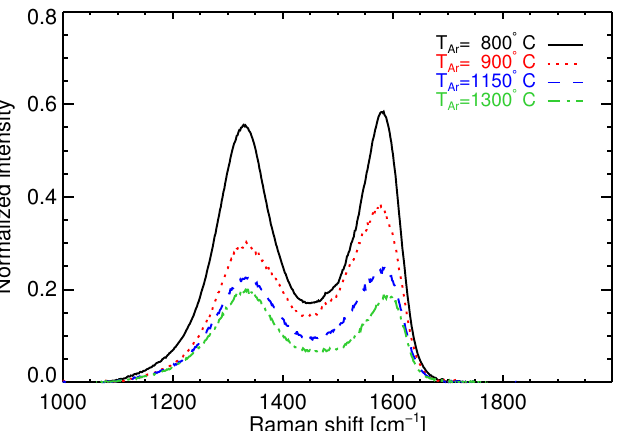
Figure 2. Normalized average µ -Raman scattering spectra obtained over 3 µ m × 3 µ m maps for the buffer layer samples with different T Ar , indicated in the